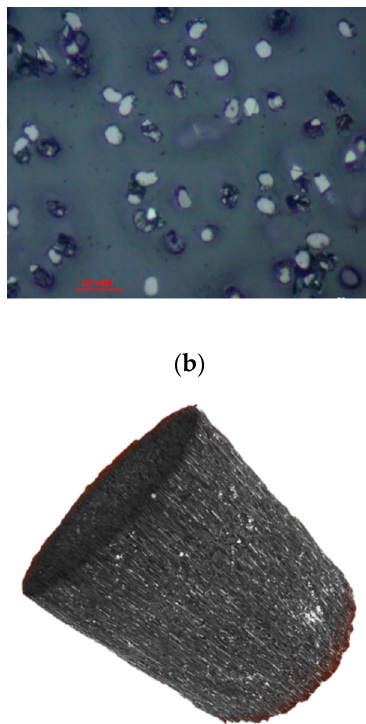
indicating fiber and void distribution ( a ), magnified (500×) microscopic view of the cross-section ( b ),